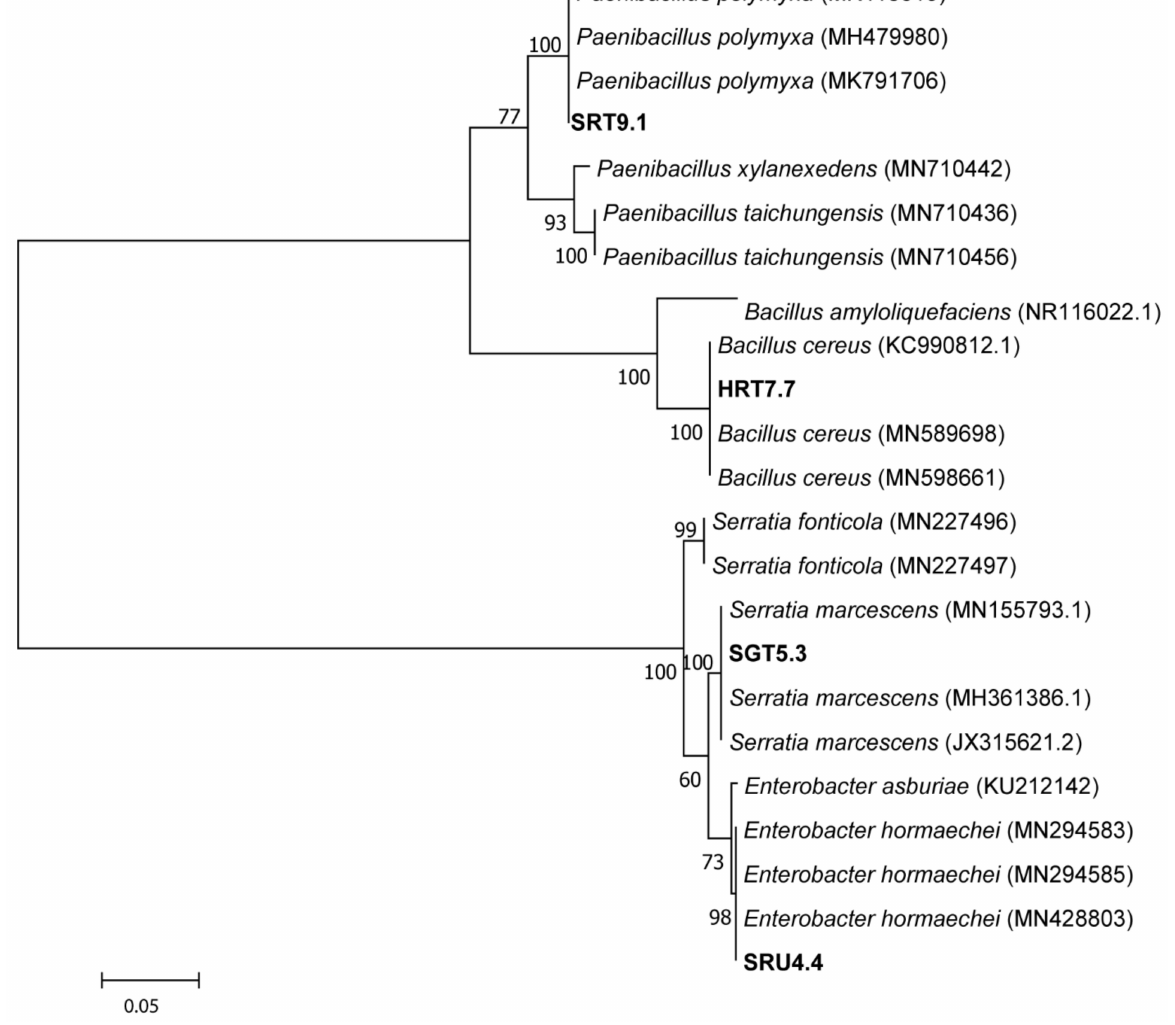
Figure 1. Neighbor-joining phylogenetic tree based on 16S rRNA gene sequences of potential antagonistic strains showing the relationship of closest type strain sequences. The phylogenetic tree was constructed using the neighbour-joining algorithm. The tree is based on 1000 resampled datasets and the numbers on branches indicate the percentage level of bootstrap